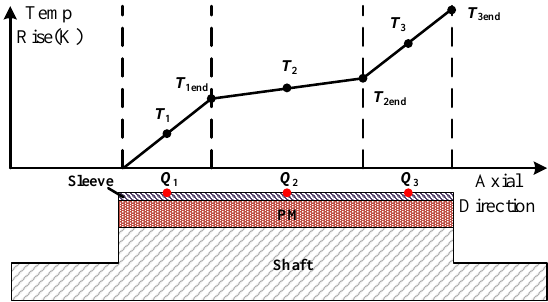
Figure 6. The fluid temperature rise